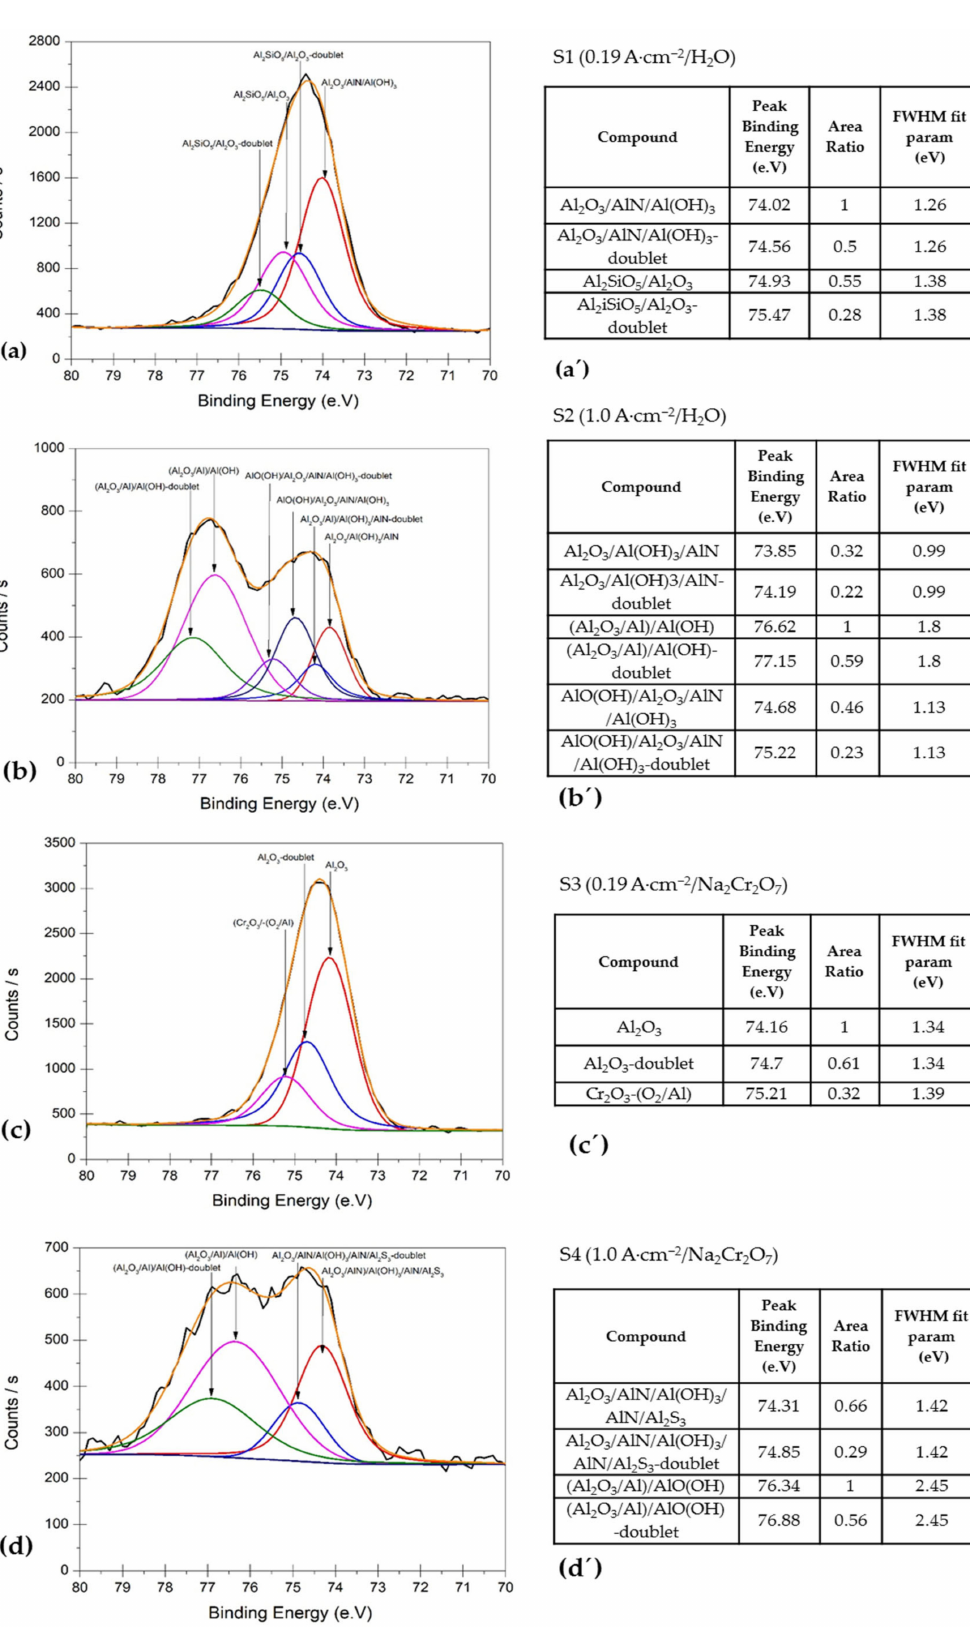
Figure 5. X-ray photoelectron spectra for Al-Li AA2055 alloy anodized: ( a ) Al 2p/S1, ( b ) Al 2p/S2, ( c ) Al 2p/S3, ( d ) Al 2p/S4. Parameters obtained from the peak binding energy and (FWHM) fitting ( a’ ) S1, ( b’ ) S2, ( c’ ) S3, ( d’ )